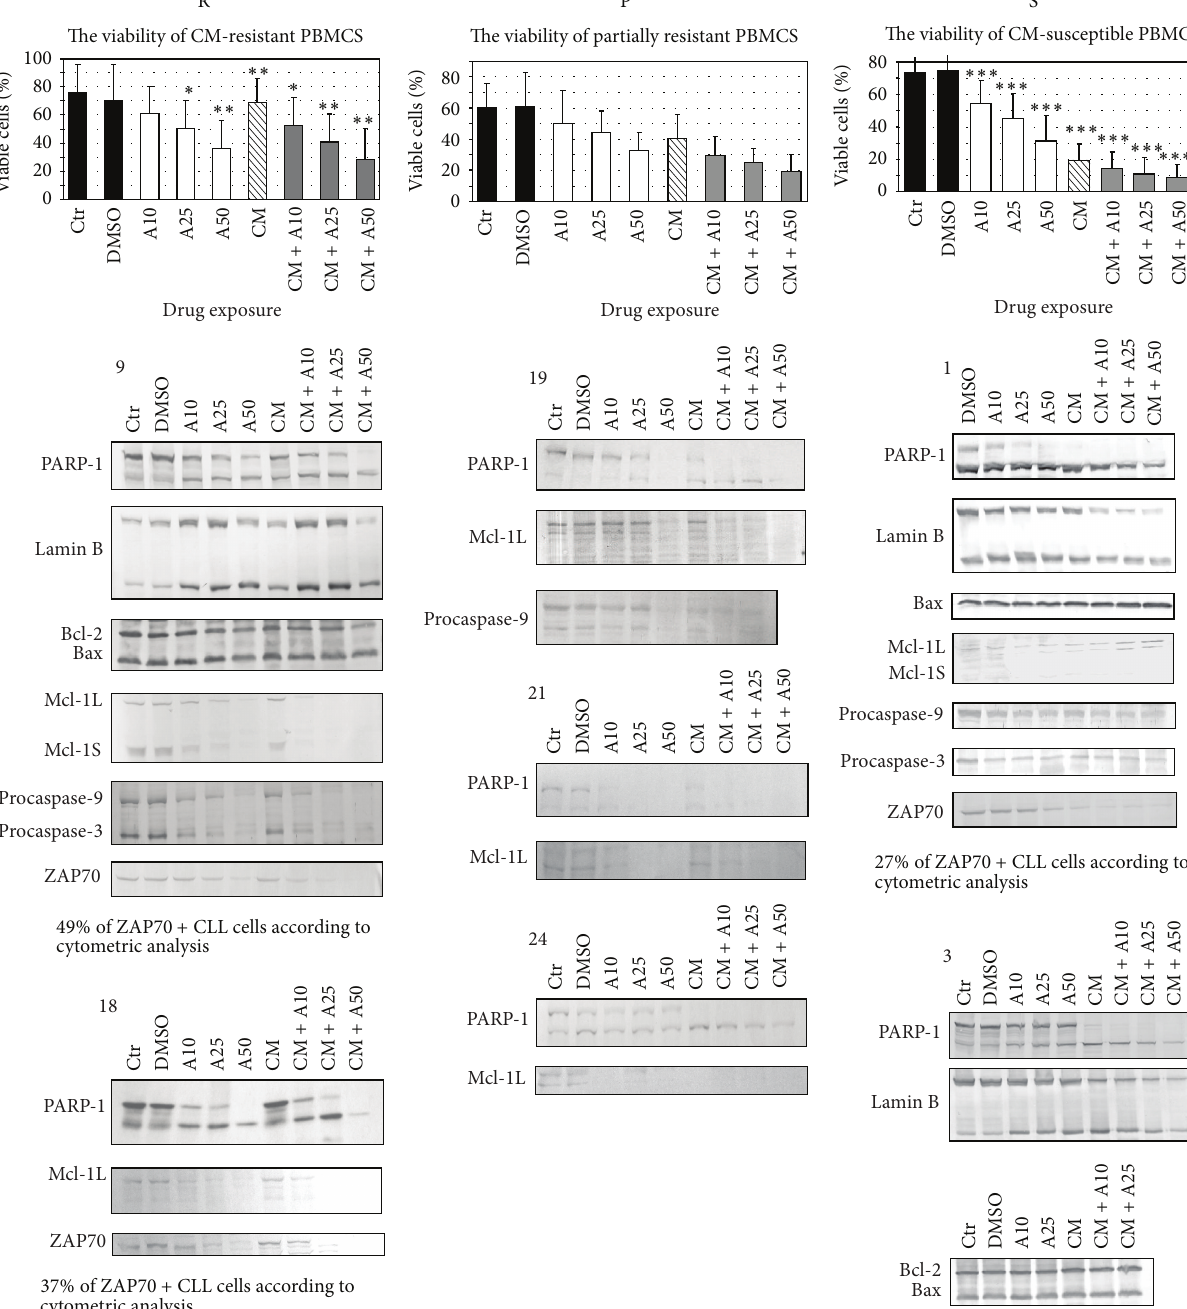
Figure 2: Antileukemic potential of atorvastatin (A), cladribine + mafosfamide combination (CM), or atorvastatin in combination with cladribine+mafosfamide(CM+A)inCM-resistant(R),partiallyresistant(P),andCM-susceptible(S)PBMCsamplesobtainedfrombloodof exemplary CLL patients (numbers 1, 3, 9, 18, 19, 21, and 24). The cytotoxic potential of the tested compounds was evaluated by Permeable/Dead Cell Apoptosis Kit and their proapoptotic activity was assessed by Western blot analysis of apoptosis-related protein expression after 48 h exposure. The results were statistically significant at ∗ 𝑝 ≤ 0.05 , ∗∗ 𝑝 ≤ 0.02 , and ∗∗∗ 𝑝 ≤ 0.002 (Wilcoxon signed rank